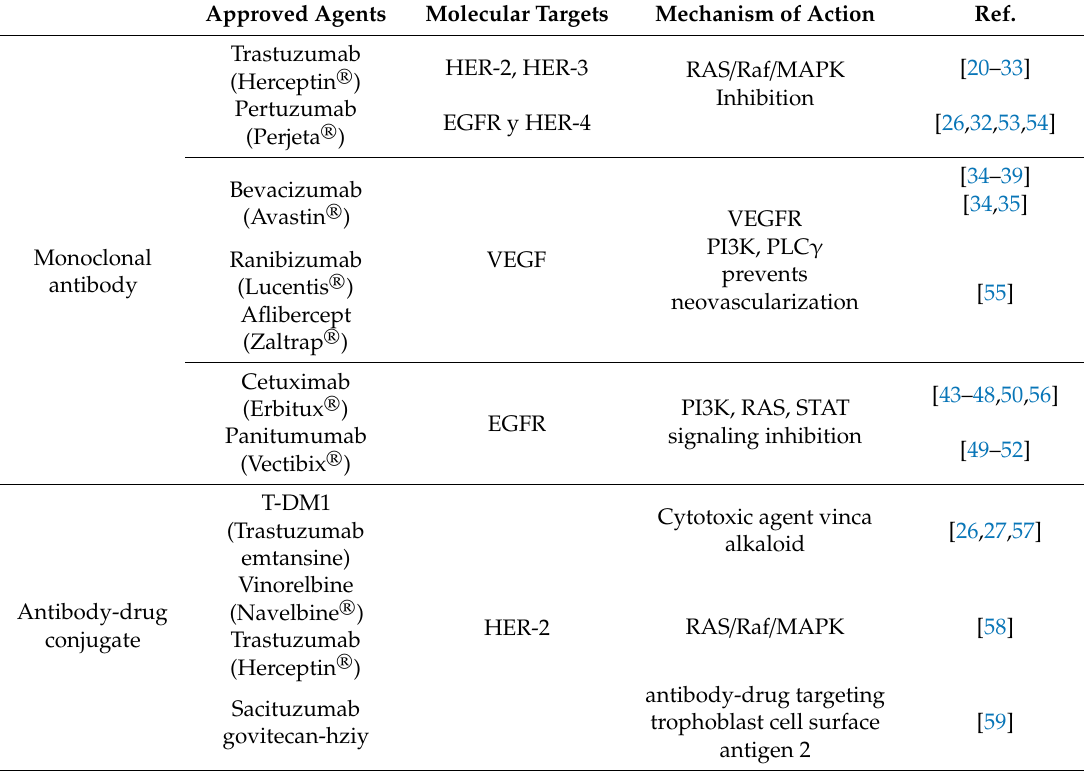
Table 1. List of monoclonal antibodies approved for targeted therapy in breast